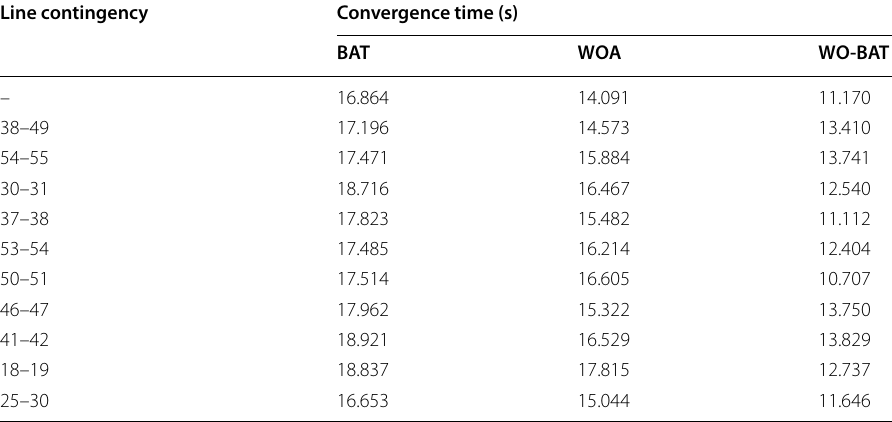
Table 7 Comparison convergence time (s) for three